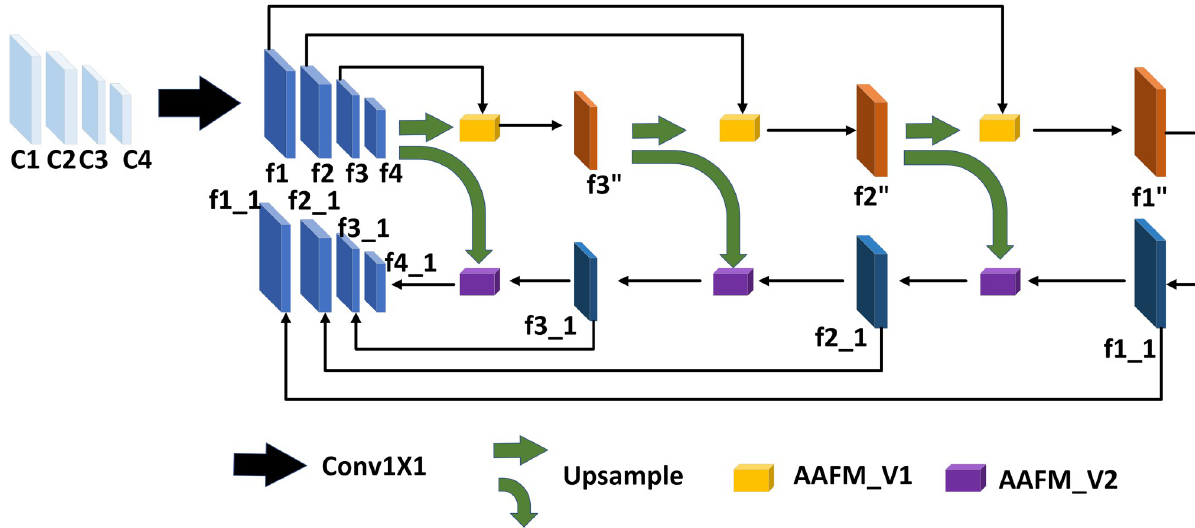
Fig 2. The proposed cross-scale attention aggregation FPN network